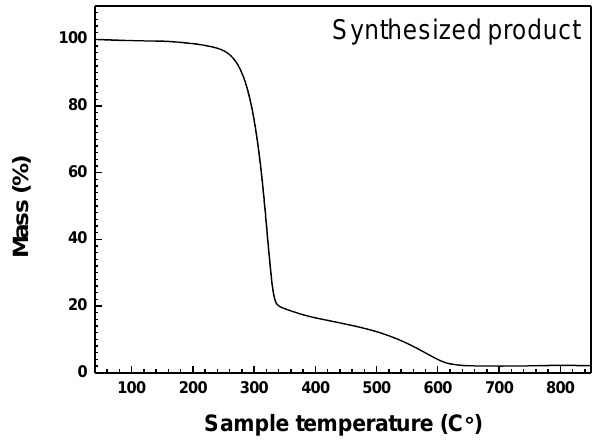
Figure 8. TGA analysis of product synthesized from a Ga(NO 3 ) 3 ∙32H 2 O pellet and C 3 H 6 N 6 powder injection with NH 3 gas by the thermal plasma process in Plasma 3.